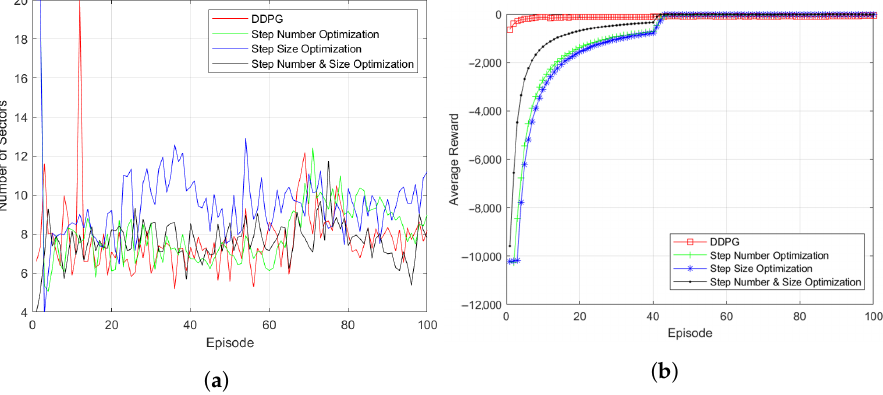
Figure 9. Simulation results of step optimization: ( a ) Subspace Change. ( b ) Episodic